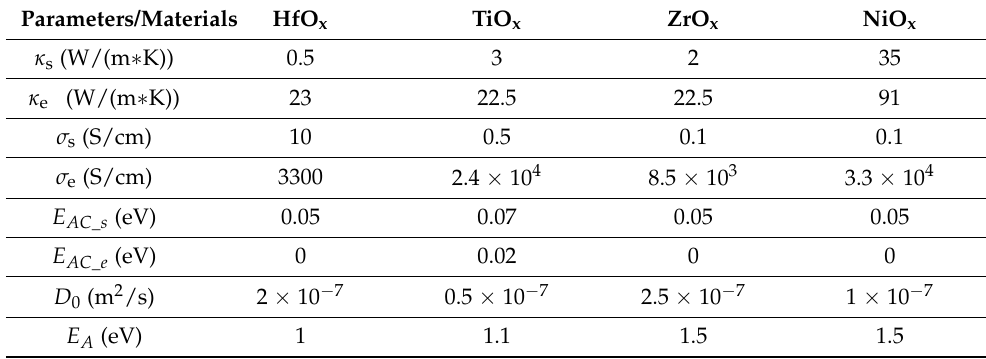
Table 1. Physical parameters of metal oxide materials [22,31–35].